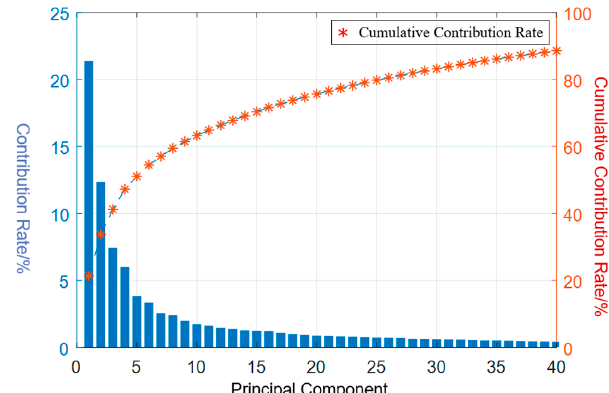
Figure 5. Principal component contribution rate and cumulative contribution rate.